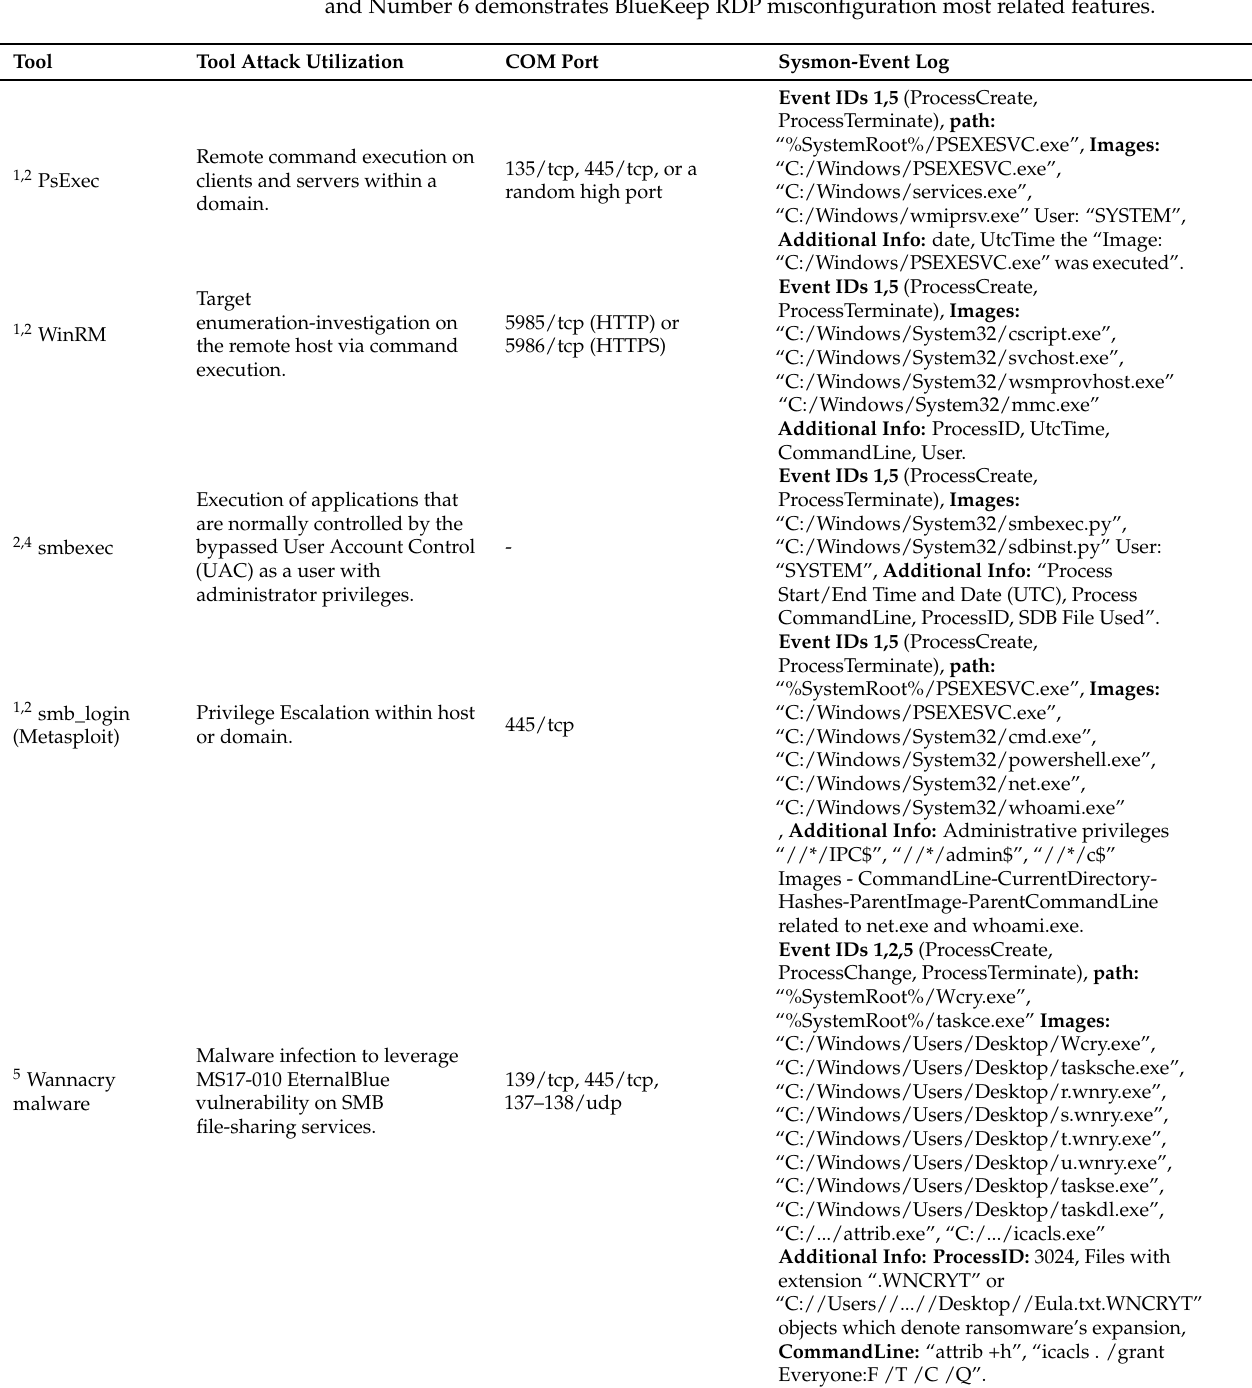
Table A1. Summary of the most important rule-based features included in Section 6.1. The imported superscripts are described as follows: Number 1 of the first column denotes Microsoft’s vulnerability with code MS-17-010 “EternalChampion SMB Remote Command Execution”, Number 2 indicates Impacket Python scripts exploitation, Number 3 is related to “Escalation to SYSTEM privilege with Metasploit smb_login exploitation”, Number 4 presents UAC bypass–privilege escalation with smbexec.py, Number 5 is the exploitation of the EternalBlue vulnerability on SMB file-sharing services, and Number 6 demonstrates BlueKeep RDP misconfiguration most related